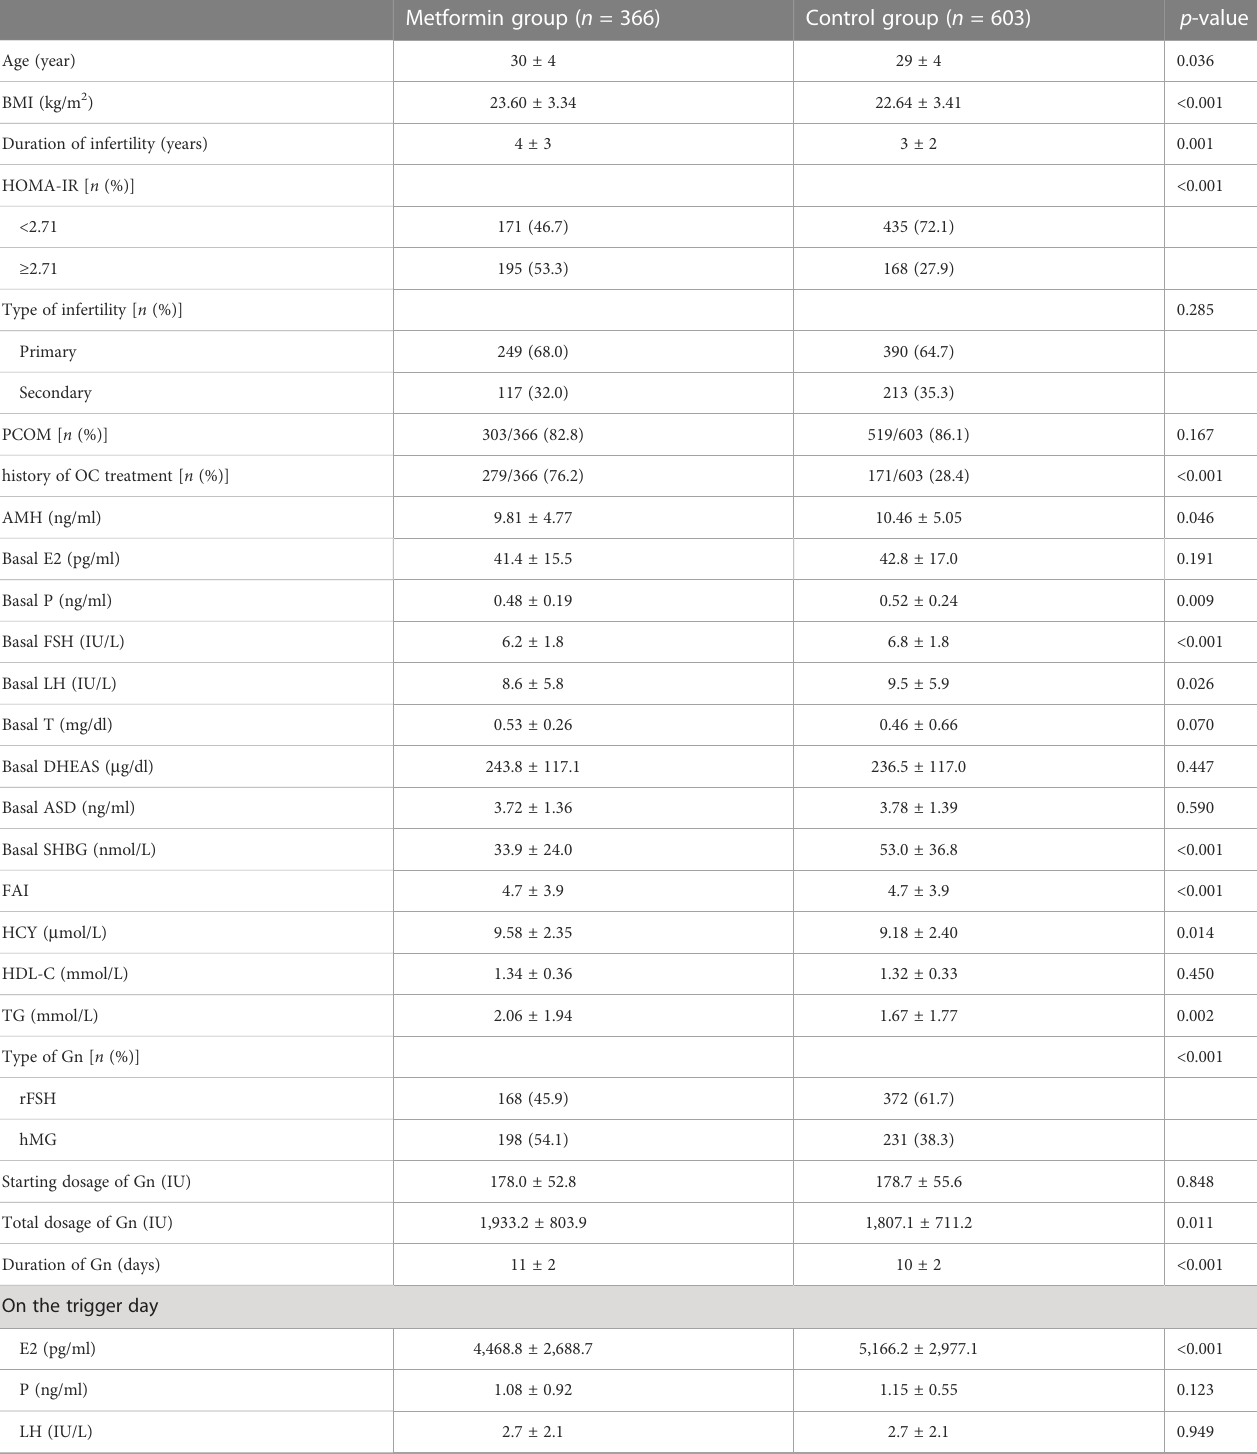
TABLE 1 Baseline information and laboratory data between the metformin group and the control